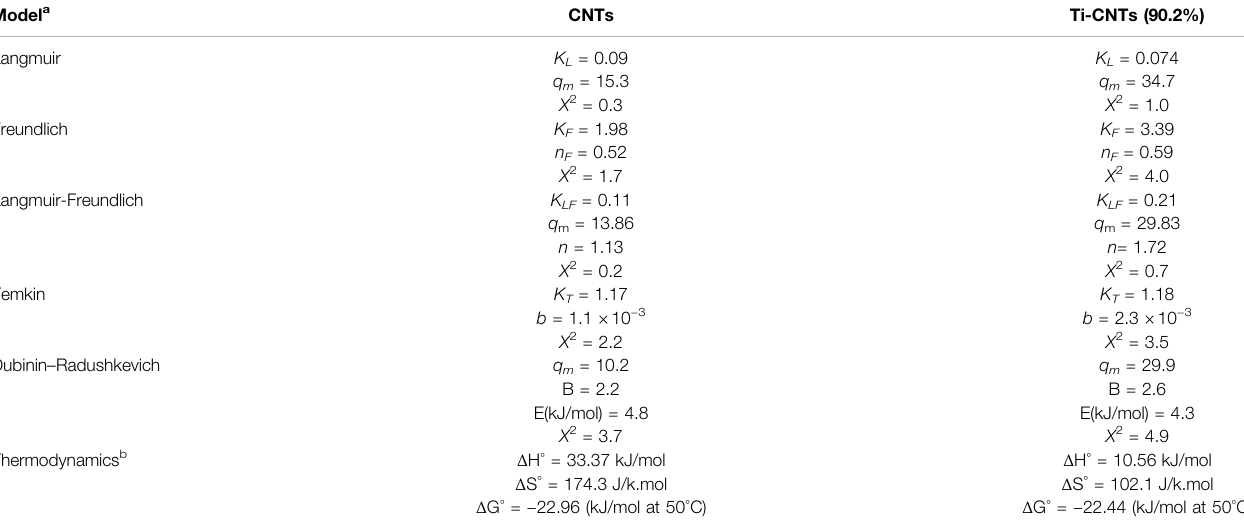
TABLE 3 | Parameters of the tested isotherms and thermodynamic values of Co retention by CNTs and Ti-CNTs. Model a